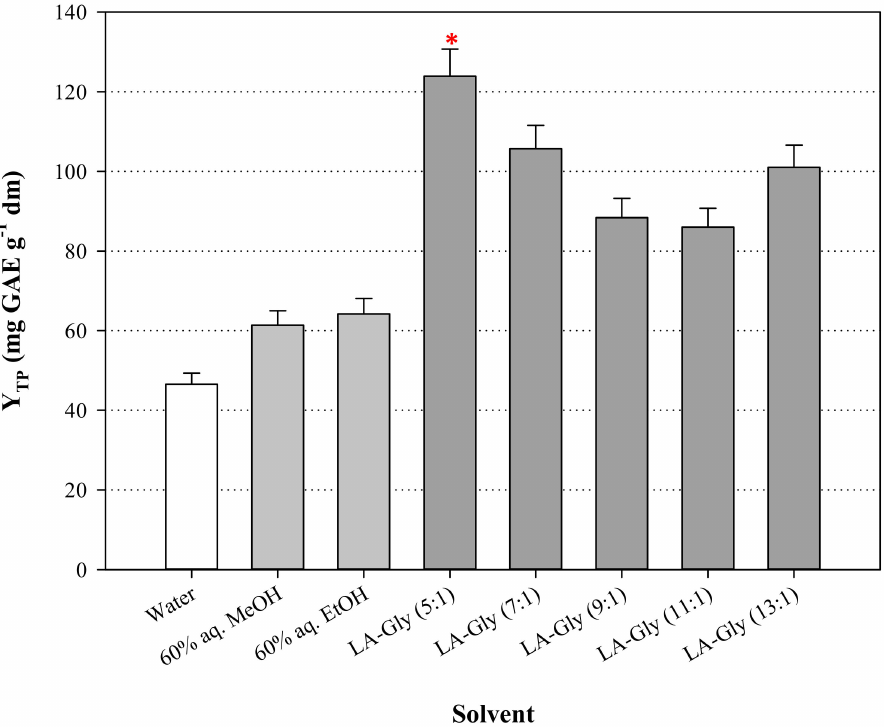
Figure 1. Bar diagram illustrating the e ff ect of the extraction e ffi ciency of the DES tested. Extractions were performed with C DES 70% ( w / v ), R L / S 35 mL g − 1 , at 50 ◦ C and 500 rpm, for 150 min. Asterisk (*) indicates statistically di ff erent value ( p <